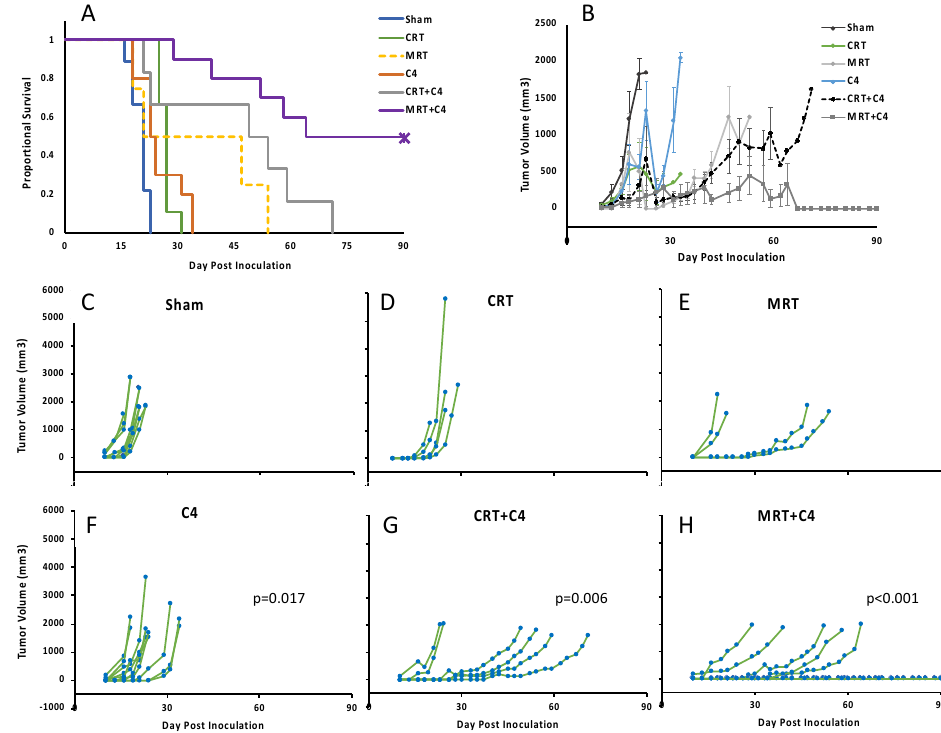
Figure 6. Treatment efficacy of various treatment modalities. ( A ) Kaplan–Meier curve demonstrates the fraction of the mice that survived at different time-points after tumor cell inoculation. ( B ) Median tumor volumes in different treatment group; error bars are SE. ( C – H ) Tumor size at different time-points after tumor inoculation in the different treatment groups, the p -values calculated by log-rank test and adjusted using FDR. CRT = conventional radiation therapy; MRT = microplanar radiation therapy; C4 = anti-CTLA-4.